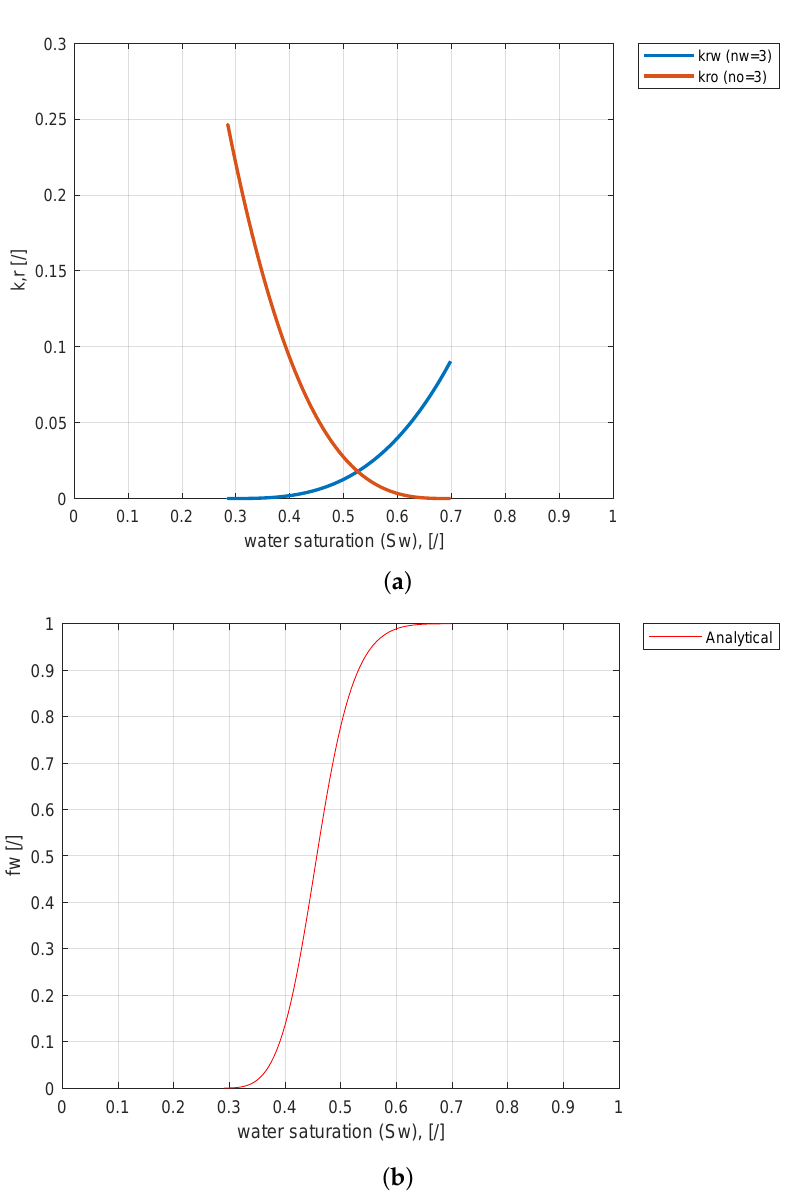
Figure 10. Relative permeability curves of oil and water during waterflooding ( a ); the fractional flow curve of water ( b